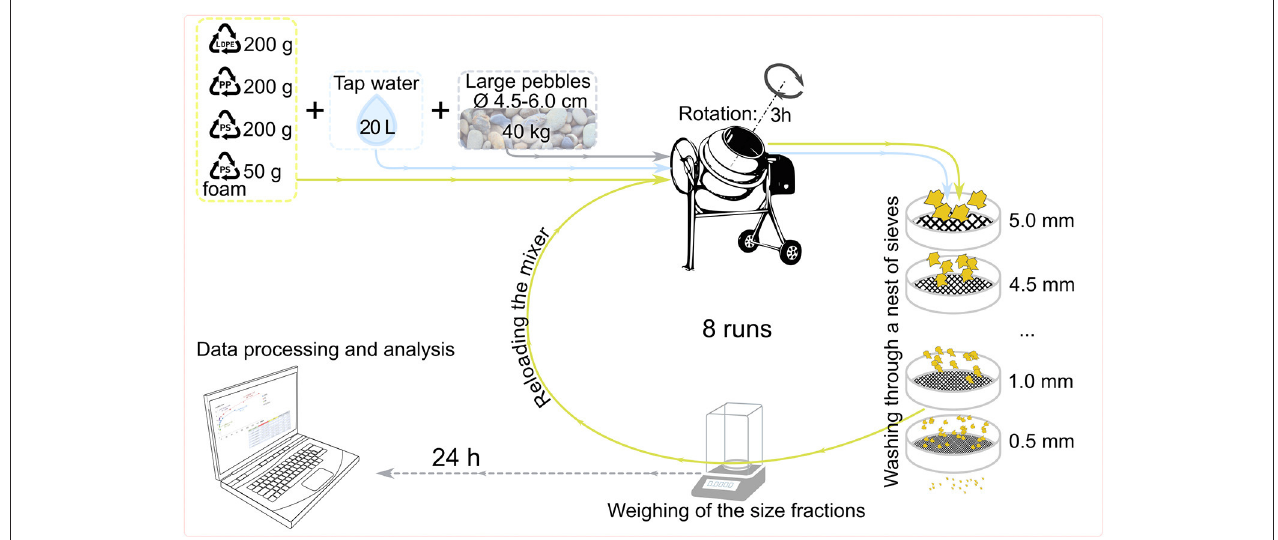
FIGURE 3 | The main stages of the experimental